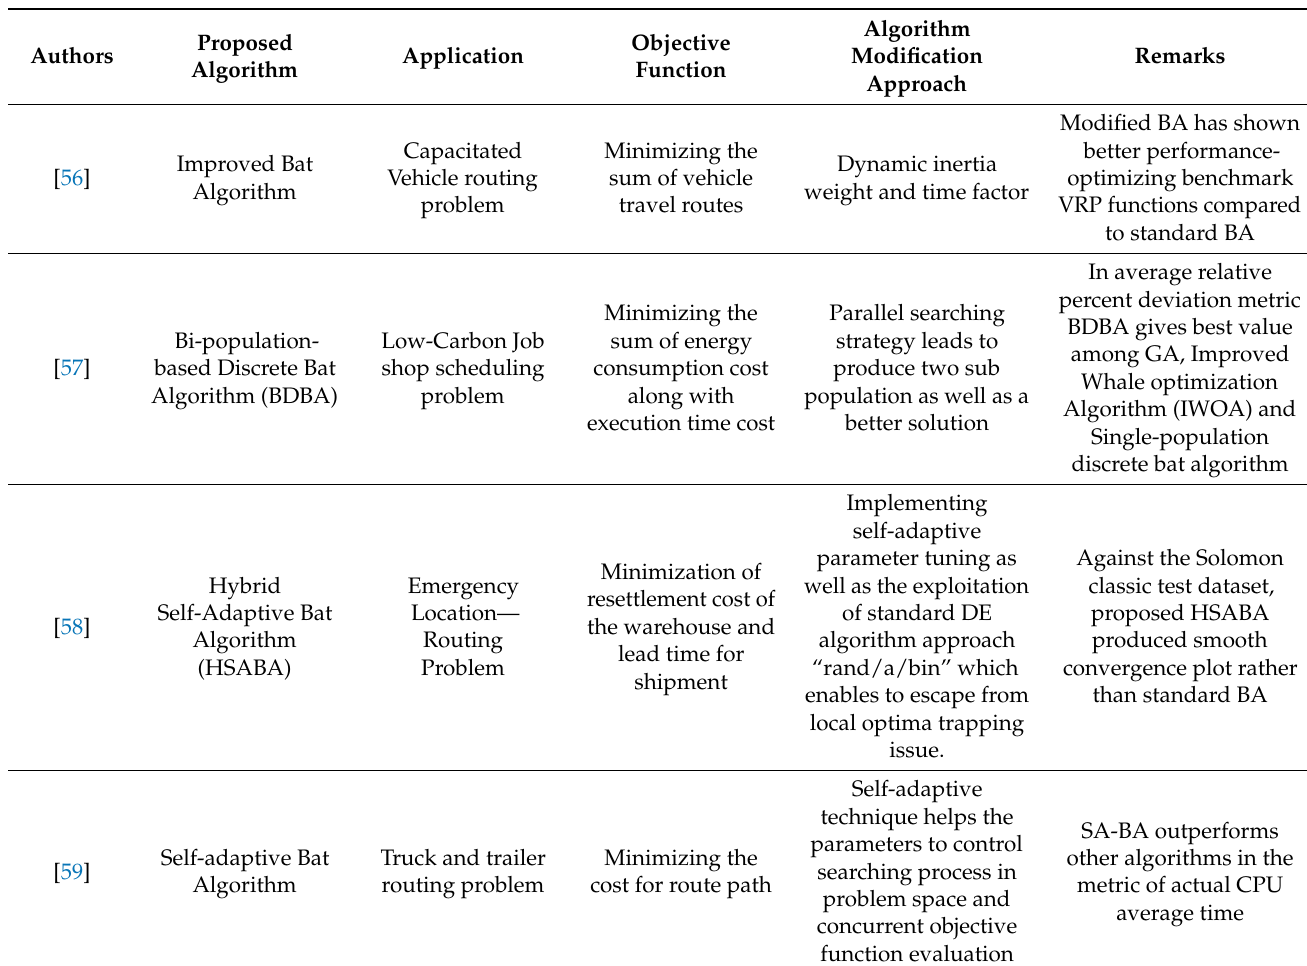
Table 4. Bat Algorithm implementation in several CO